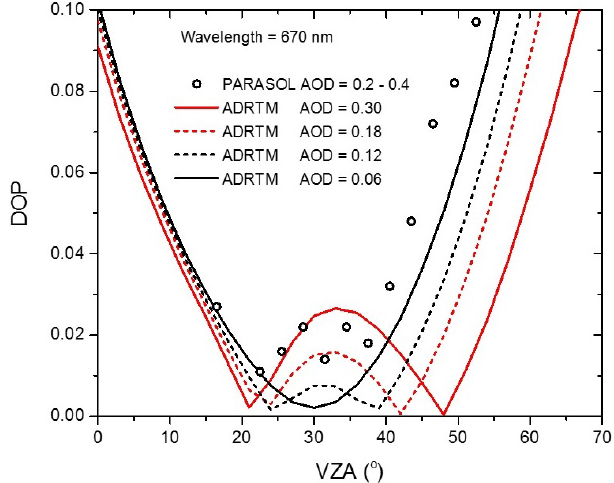
Figure 1. At near-backscatter angles (for this case, it is at view- ing zenith angle (VZA) =∼ 20–40 ◦ and relative azimuth angle (RAZ) =∼ 170–180 ◦ ), the DOP of light from dust monotonically increases with the AOD of dust aerosols. In this modeling, the adding–doubling radiative transfer model (ADRTM) developed in Sun and Lukashin (2013) is used. The wavelength is 670nm, the solar zenith angle (SZA) is 30 ◦ , and the wind speed over the ocean surface is 7.5ms − 1 . Also shown in this figure are the PARASOL measurements obtained over the Atlantic Ocean area (0–35 ◦ N and 0–60 ◦ W) that has Sahara dust; 12d of PARASOL data in May– August 2006 are used for this study. The results are for a RAZ of 177 ◦